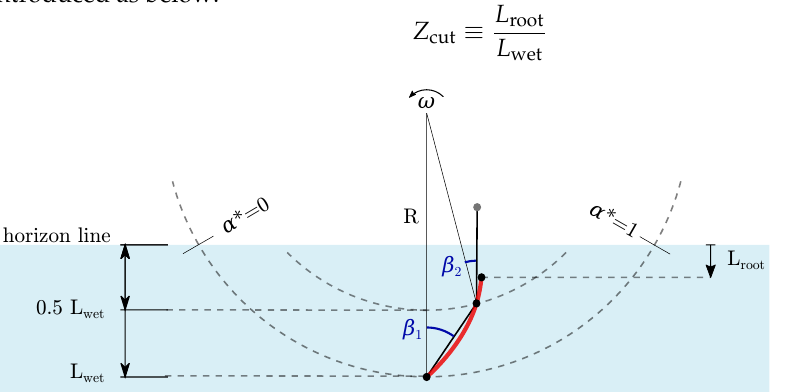
Figure 1. Schematic diagram of the parametrised water wheel geometry studied in this work, in which one blade is shown with a red thick spline (the number of blades is a variable in this study). This spline connects three points positioned using two angles β 1 and β 2 , as in the previously published optimisation [17]. In this work, the altitude of those points is not modified, but the blade is “cut” (shortened) so that its root is located at a variable distance L root from the horizon line. Water flows from left to right with free-stream velocity U ∞ , and the wheel rotates in the anti-clockwise direction with angular velocity ω